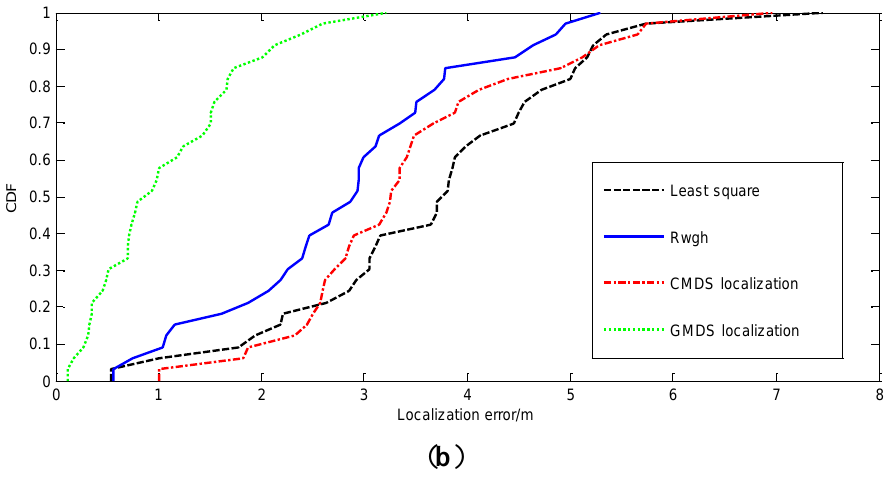
Figure 8. Performance of the tracking algorithms when 3 when 3 N  ; ( b ) Diagram of cumulative error distribution when 3 nlos